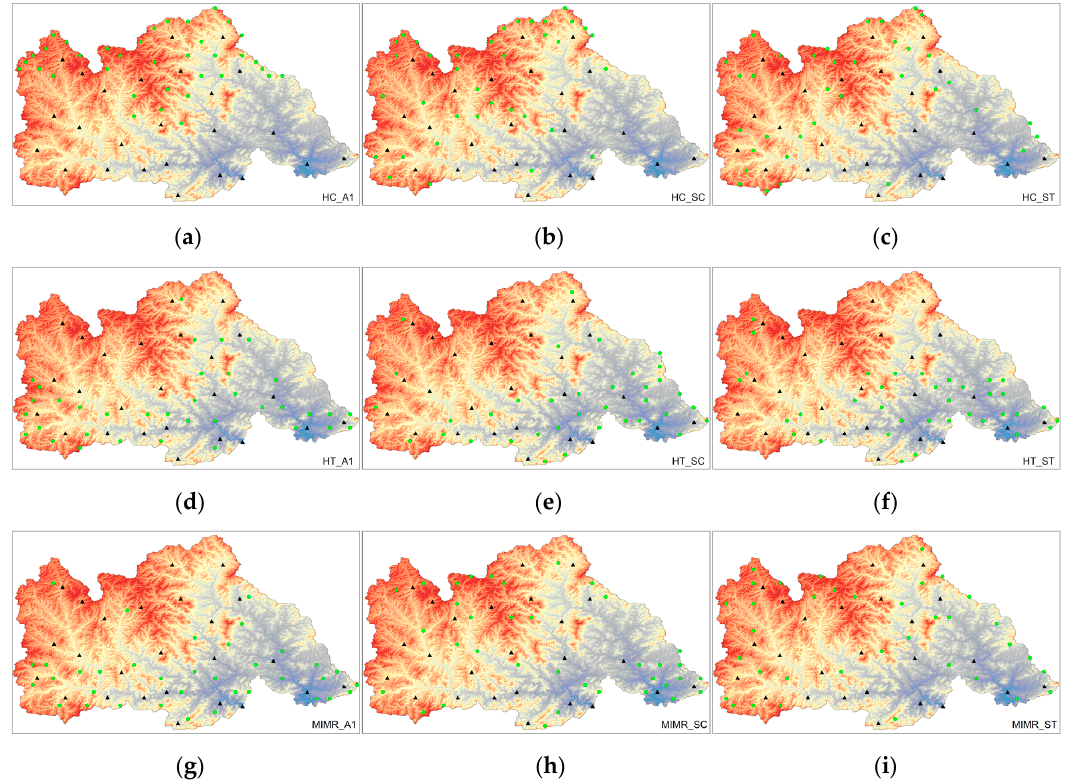
Figure 3. Optimization design results of a network with 60 rain gauges. ( a ) Network of HC layout method using A1 discrete method; ( b ) Network of HC layout method using SC discrete method; ( c ) Network of HC layout method using ST discrete method; ( d ) Network of HT layout method using A1 discrete method; ( e ) Network of HT layout method using SC discrete method; ( f ) Network of HT layout method using ST discrete method; ( g ) Network of MIMR layout method using A1 discrete method; ( h ) Network of MIMR layout method using SC discrete method; ( i ) Network of MIMR layout method using ST discrete method; the black points are existing rain gauges, and colored points are added rain gauges.